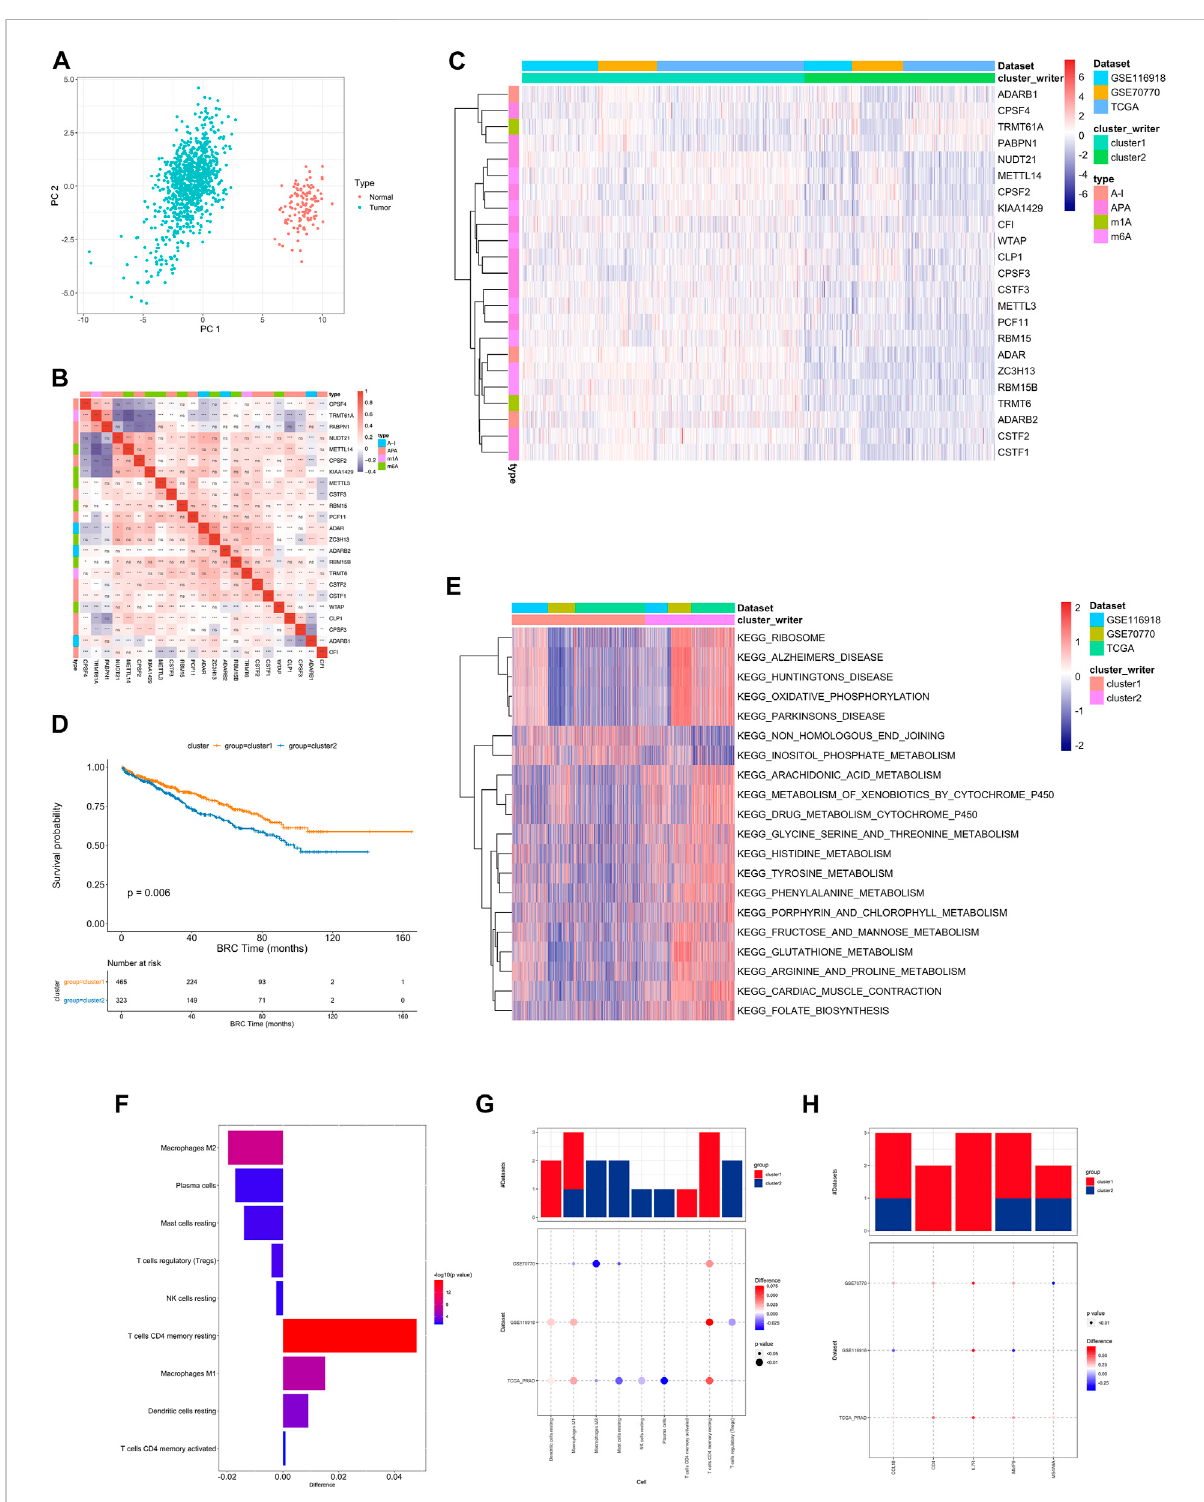
FIGURE 2 (A) PCA analysis of RNA writers between normal (red dot) and tumor (green) samples. (B) The difference in the relative abundance of immune cell in fi ltration in TME between RNA modi fi cation Cluster_1 and RNA modi fi cation Cluster_2 was calculated by the CIBERSORT algorithm. Difference > 0 indicates that the immune cells were enriched in RNA modi fi cation Cluster_1, and the column color represents the statistical signi fi cance of the difference. (C) Heatmap shows a positive (red) and negative (blue) correlation among RNA modi fi cation “ writers ” in PC. * p